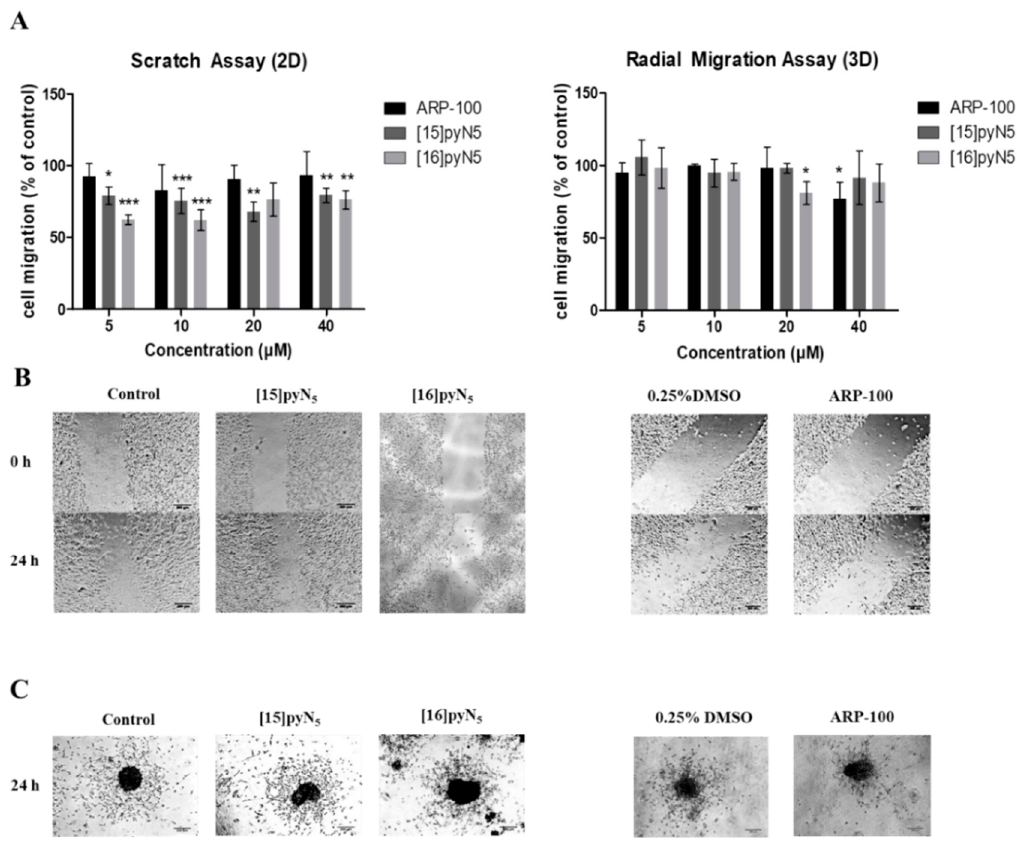
Figure 8. Effect of [15]pyN 5 , [16]pyN 5 and ARP-100 in cell migration in 2D (scratch) and 3D (radial migration) models. ( A ) Quantification of migrated cells after 24h in 2D and 3D models of MDA-MB-231 cells. Data expressed as percentage (mean ± SD, n = 3–4) relative to controls (non-treated condition for [15]pyN 5 and [16]pyN 5 and 0.25% DMSO for ARP-100); ( B ) representative images of scratch assays after 0 and 24 h upon incubation with 20 µ M of each compound and respective controls, scale bars = 200 µ m; ( C ) representative images of radial migration after 24 h upon incubation with 20 µ M of each compound and respective controls. Magnification 4 × , scale bars = 200 µ m. Statistical significance is represented as * p < 0.05, ** p < 0.01, *** p <